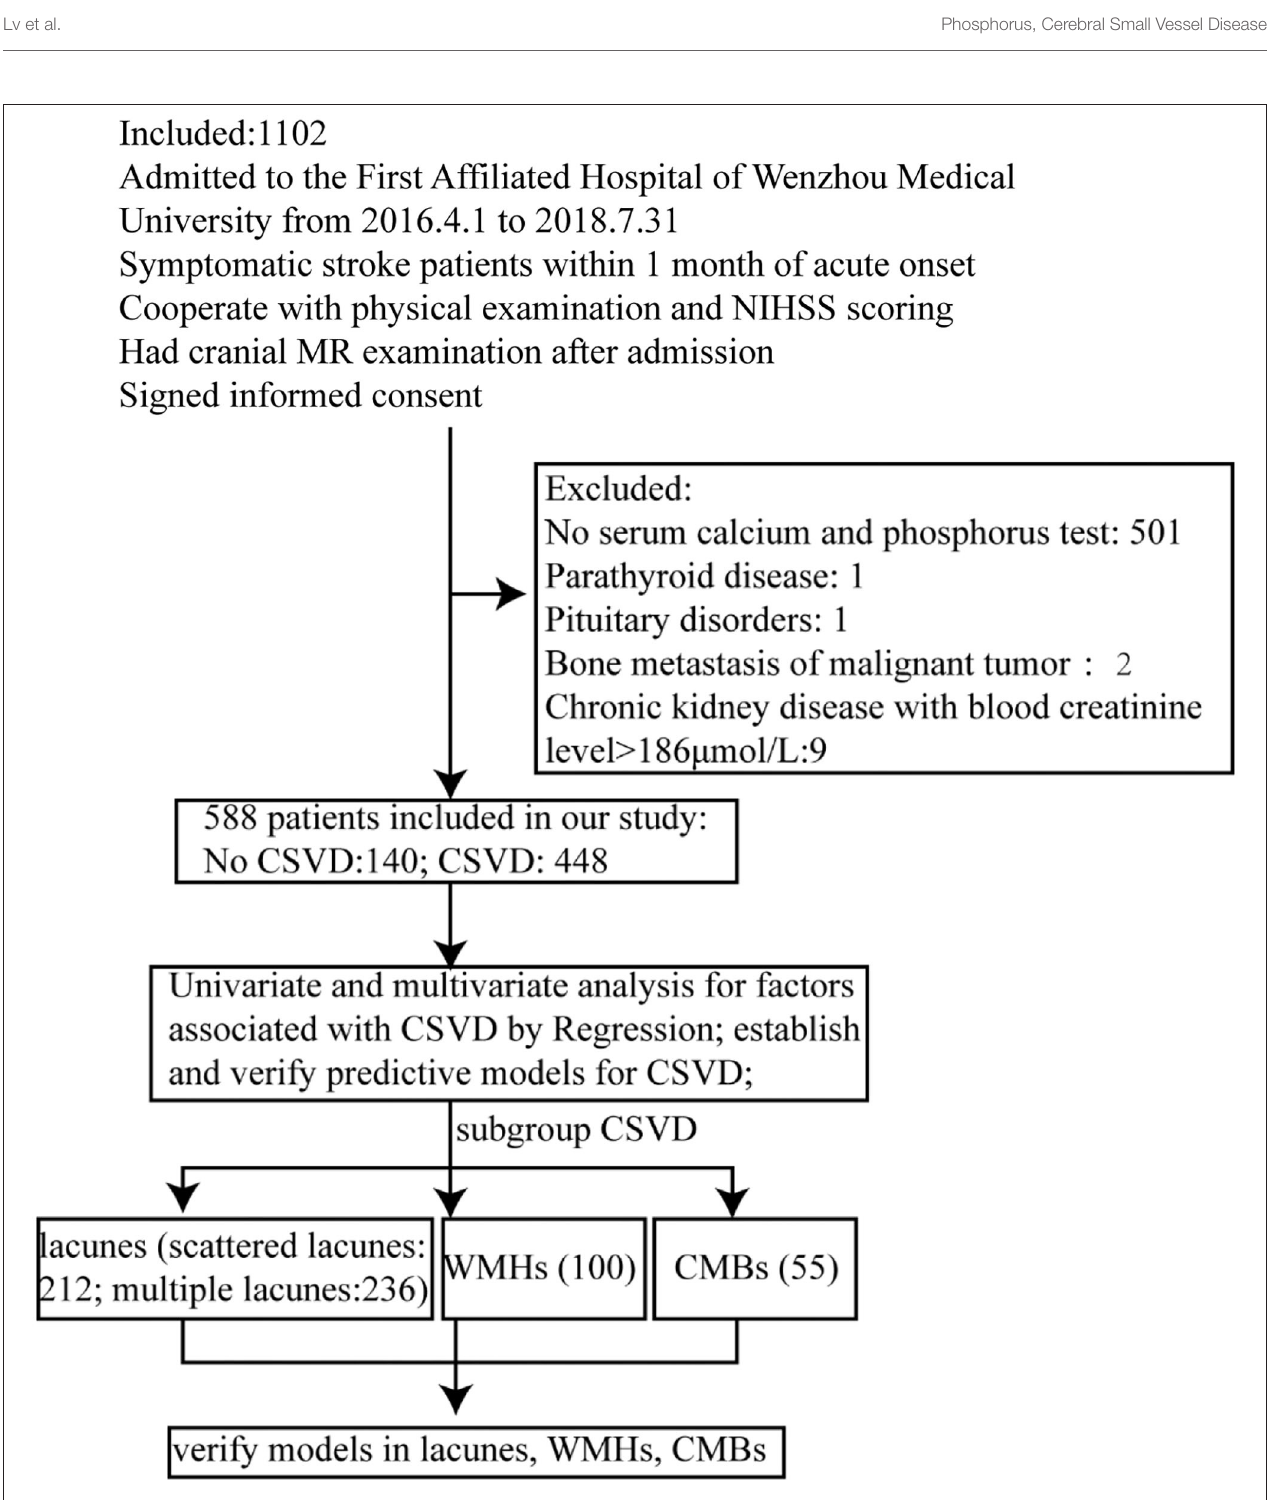
FIGURE 1 | Flow diagram showing the patient selection and data analysis.